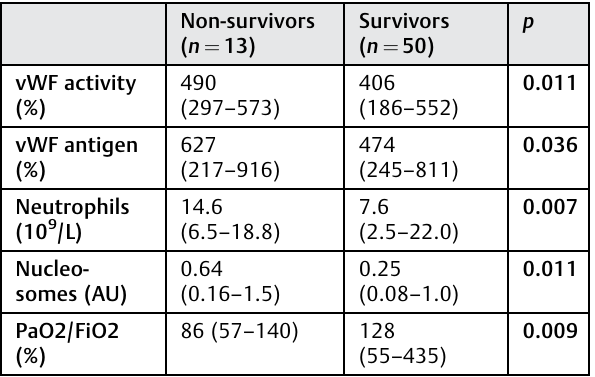
Table 6 Risk score calculation for in-hospital mortality